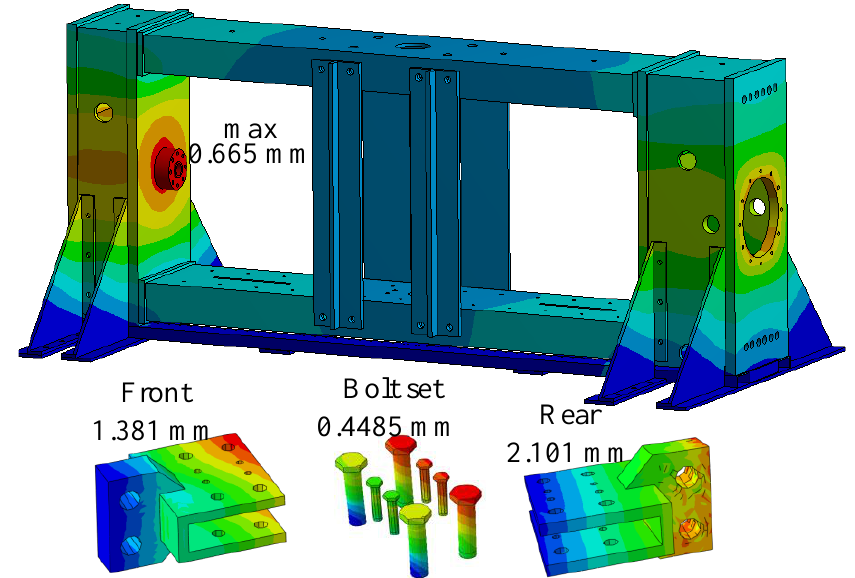
Figure 3. Loading bracket static stress analysis cloud diagram.